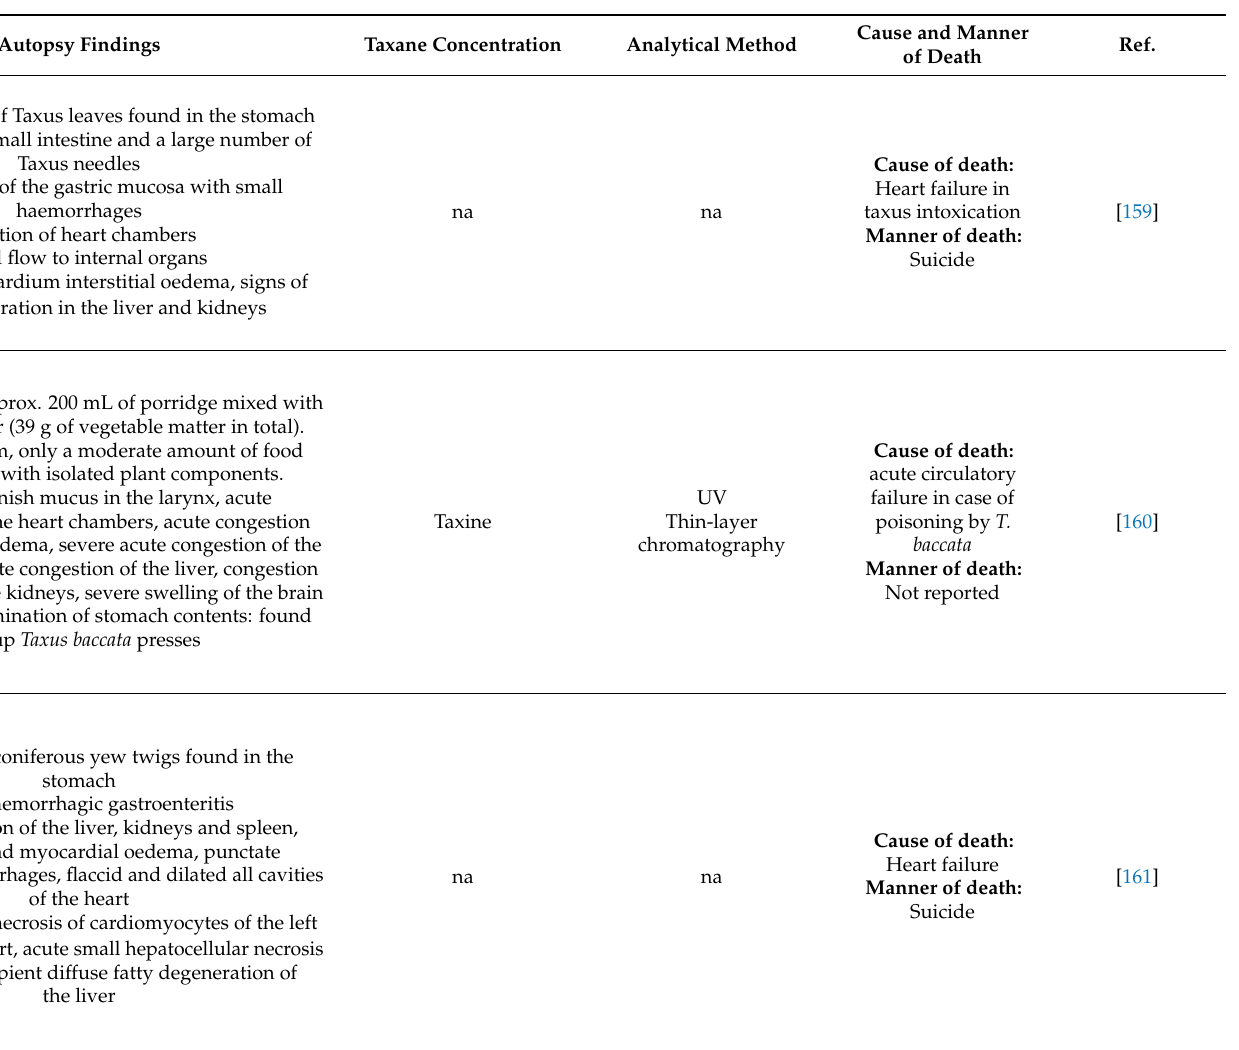
Table 4. Fatal cases of poisoning by Taxus